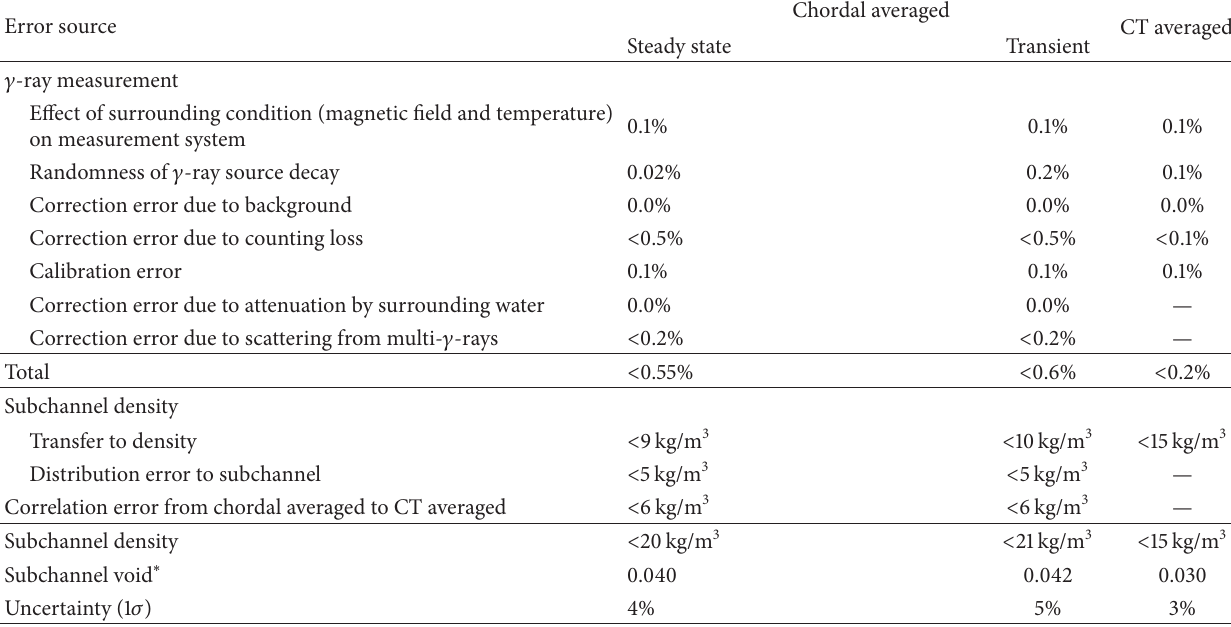
Table 10: Sources of error for void distribution measurement.